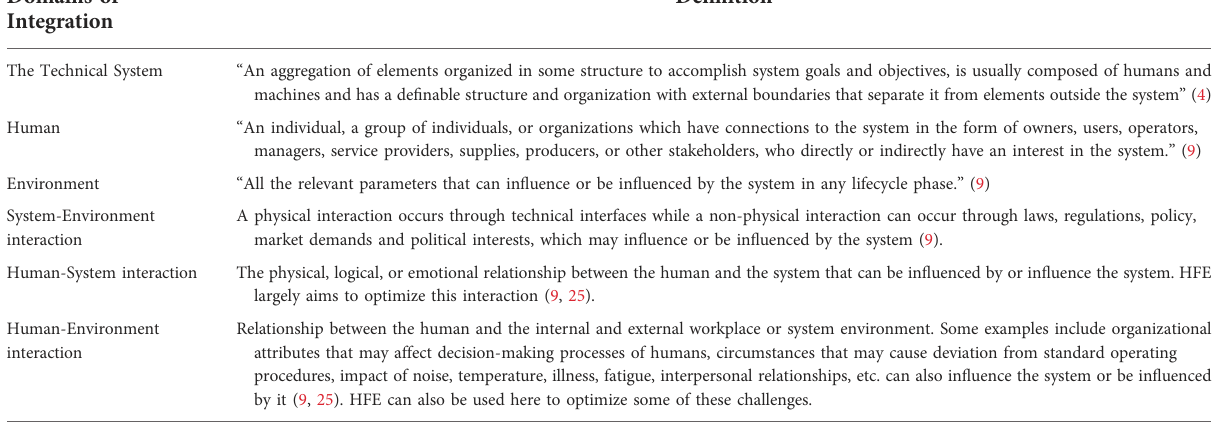
TABLE 1 Domains of integration and the interaction between them. Domains of